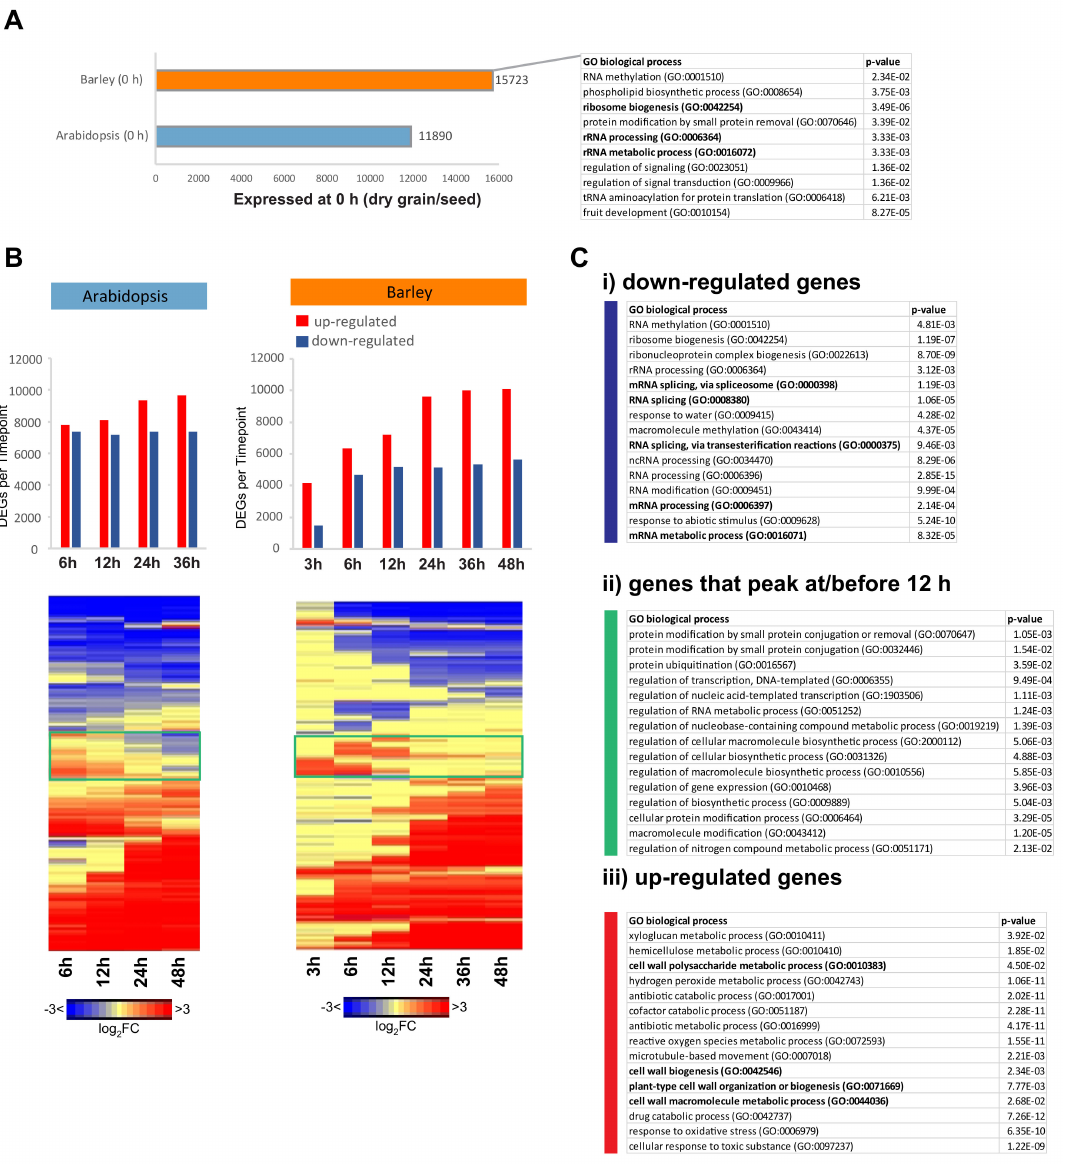
Figure 2. Transcriptome of barley grain germination. Di ff erentially expressed genes (DEGs; | log |> 1, false discovery rate (FDR) < 0.05) during the course of germination were 2 (fold-change) identified by comparing to the imbibed seed (0 h) using RNAseq. ( A ) The number of expressed genes at 0 h is shown, and those that overlapped with the Arabidopsis dry seed are indicated in bold. ( B ) The number of DEGs are shown for barely and Arabidopsis as well as the heatmaps following average linkage hierarchical clustering of the fold changes. Genes that peaked at 12 h or earlier during germination are indicated in the green boxes. ( C ) The top 15 Gene Ontology (GO) biological processes that were enriched in the (i) downregulated genes, (ii) genes that peaked at 12 h or earlier, and (iii) upregulated genes are shown. Categories are in order of fold enrichment. The functional categories that overlapped with the outputs following the same analysis in Arabidopsis are indicated in bold. All GO enrichment was carried out using Fisher’s test and Bonferroni FDR